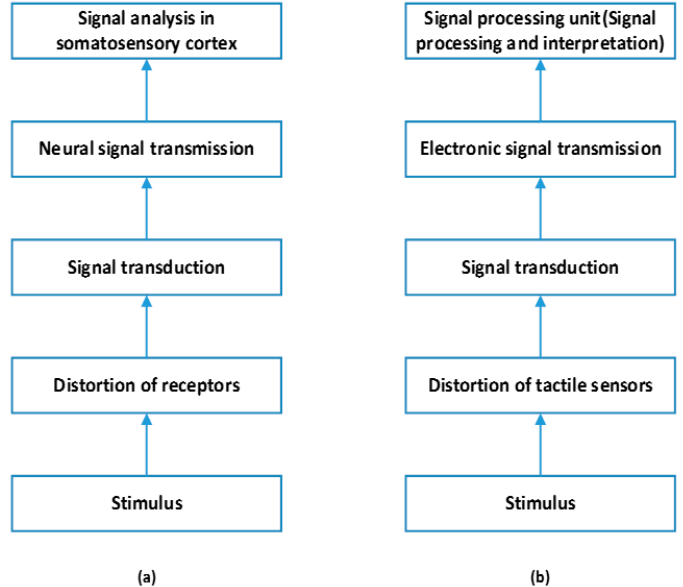
Figure 3. The illustrative hierarchical transmission of tactile signals in: ( a ) human skin; and ( b ) smart tactile sensing system.